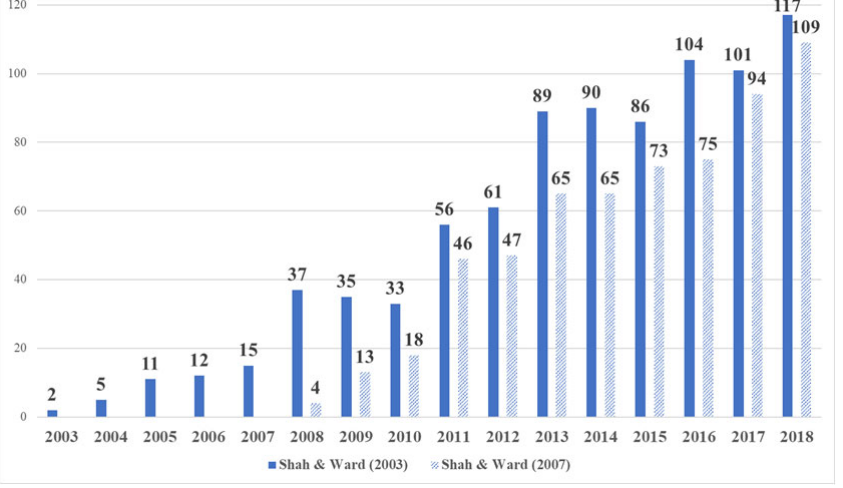
Figure 1. Transition of the citations of Shah and Ward (2003,